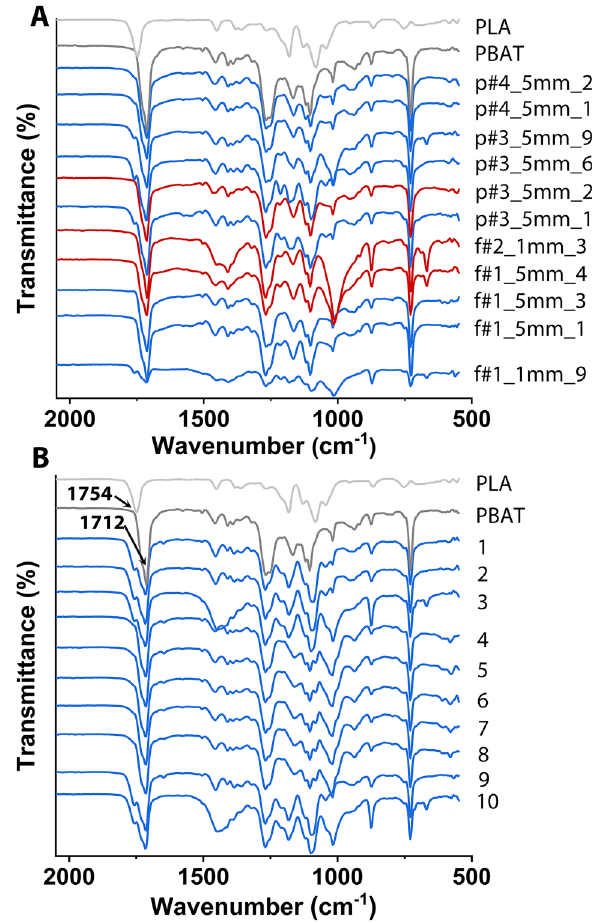
Figure 1. FTIR spectra of BDP fragments from composts and commercial bags. ( A ) BDP fragments recovered from the composts and ( B ) the commercial compostable bags. Fragments were coded as follows: p or f for pre-compost or finished compost, followed by the plant number (#1 to #4), an indication of the size fraction (> 5 mm or 1–5 mm) in which the fragment was found, and finally, the fragment number. Fragment F#1_5mm_4 therefore represents the 4th fragment collected in the > 5 mm size fraction from the finished compost of plant number 1. Bags were arbitrarily numbered 1–10, see Suppl Table S1 for supplier information. The spectra (in grey) of the reference materials for PLA and PBAT are given as basis for the interpretation. Spectra in red refer to test samples consisting only of PBAT, while those in blue indicate samples composed of PBAT/PLA